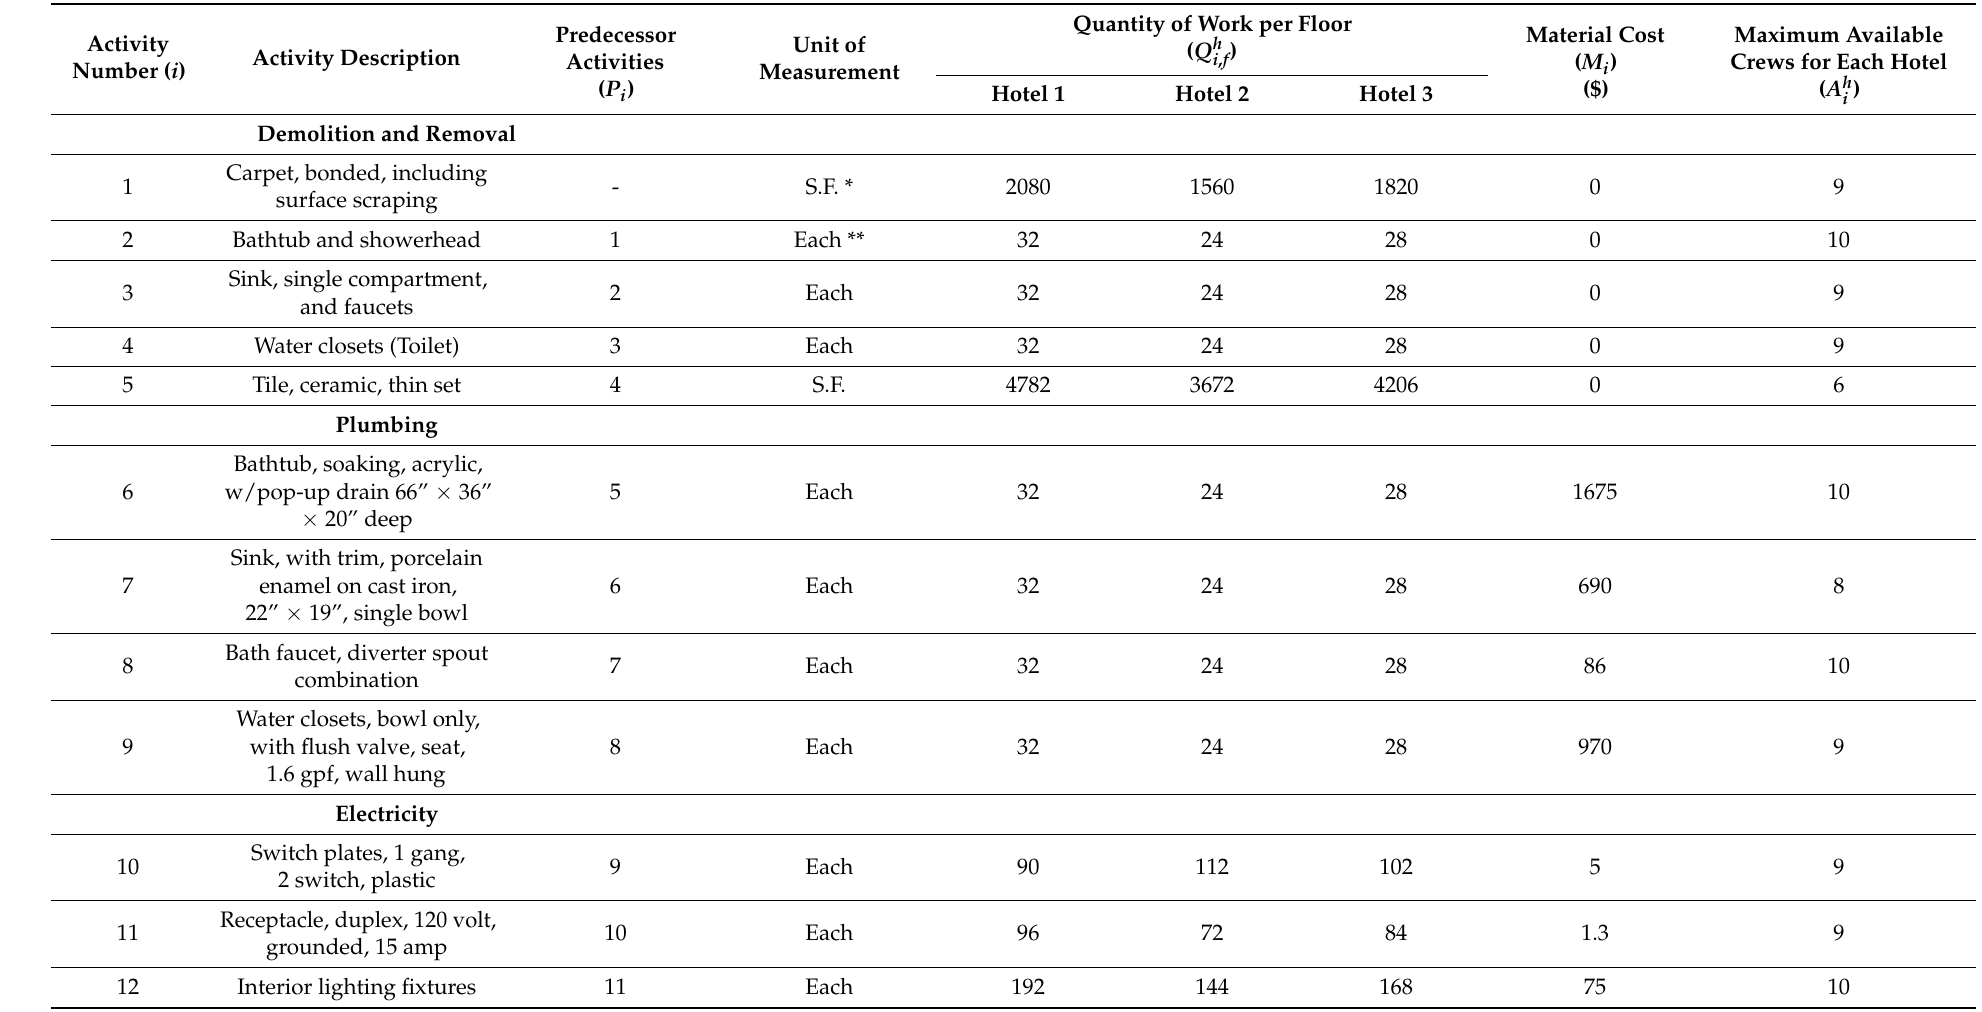
Table 1. Renovation activity